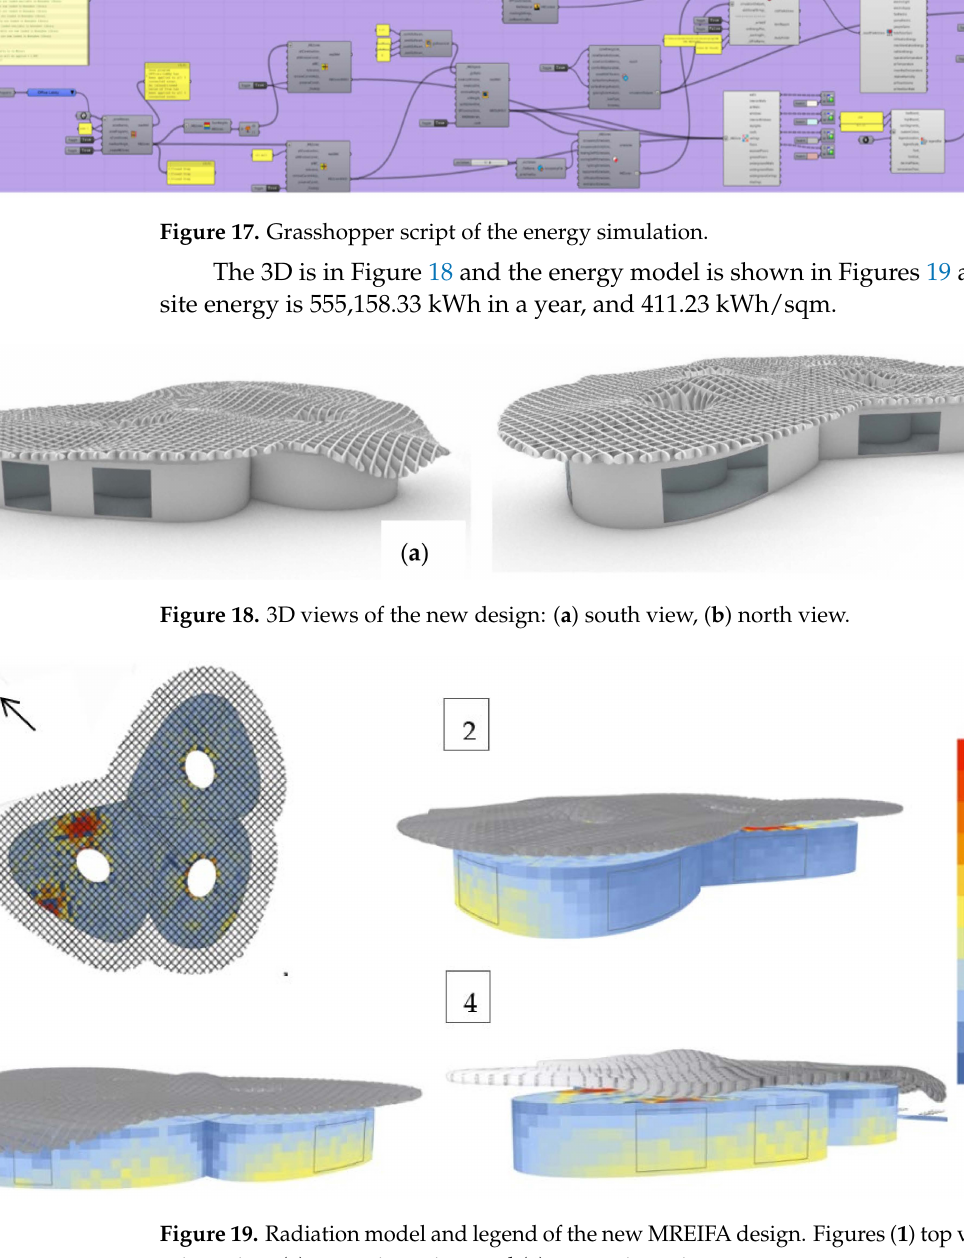
Figure 19. Radiation model and legend of the new MREIFA design. Figures ( 1 ) top view, ( 2 ) north-east orientation, ( 3 ) east orientation, and ( 4 ) west